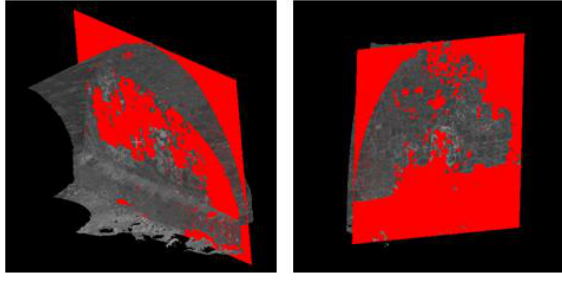
Fig. 9 Orthoimages in the intensity - GSD 2 mm